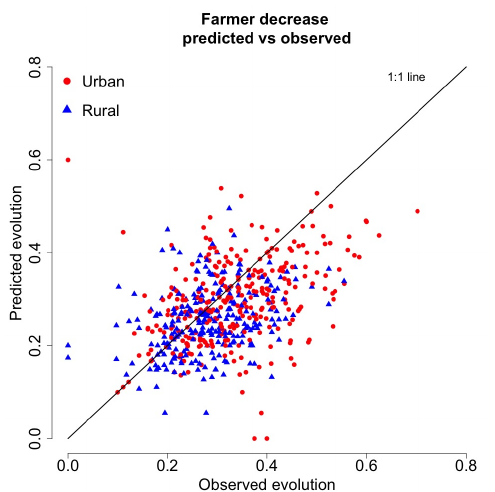
Figure 9. Observed vs. predicted percentage of farmer decrease between 2000 and 2010.